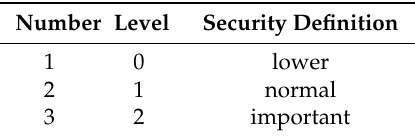
Table 3. User-specify security levels